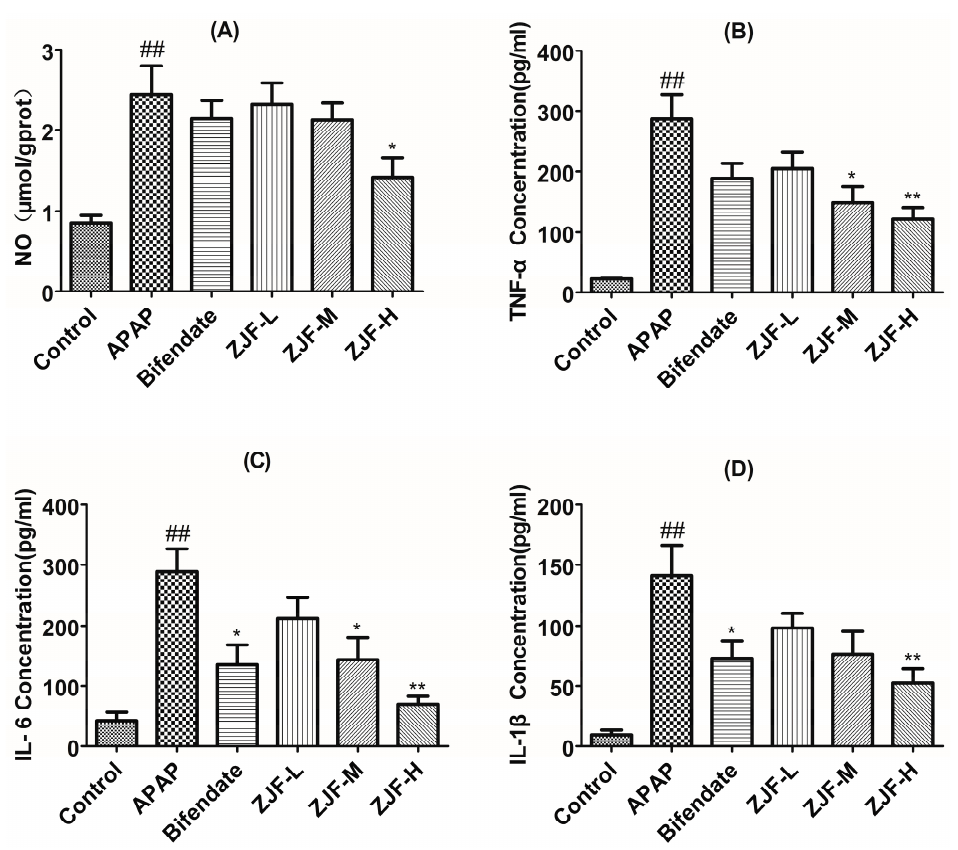
Figure 5. Preventive effects of different doses of ZJF on Nitric oxide (NO), tumor necrosis factor- α (TNF- α ), interleukin-6 (IL-6), and interleukin-1 β (IL-1 β ) levels in APAP-induced hepatotoxicity mice. ( A ) level of NO; ( B ) level of TNF- α ; ( C ) level of IL-6; ( D ) level of IL-1 β . Data are expressed as mean ± SEM, n = 6 mice per group. ## p < 0.01 vs. the control group. * p < 0.05 and ** p < 0.01 vs. the APAP group.